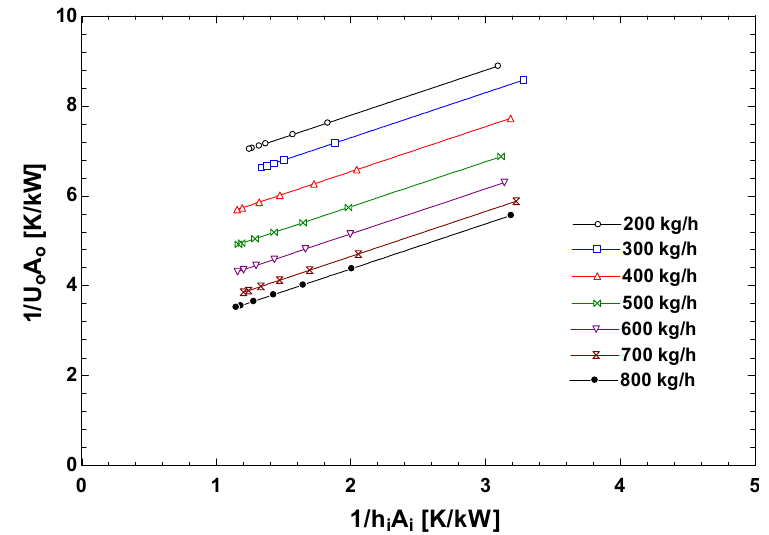
Figure 4. Wilson plots with variation of the annular-side mass flow rate.